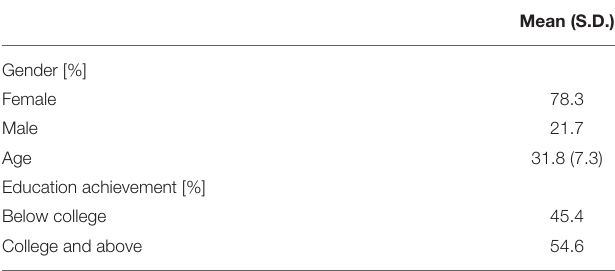
TABLE 1 | Profile of the